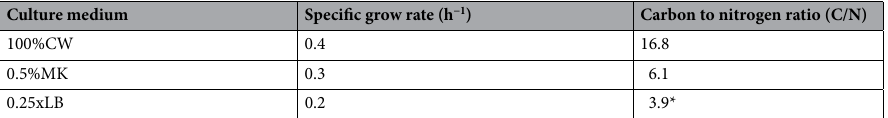
Table 1. Specific growth rate of R. ruber S103 grown in different culture media and their carbon to nitrogen ratio. *C/N ratio of LB was obtained from Mouginot et al. 48